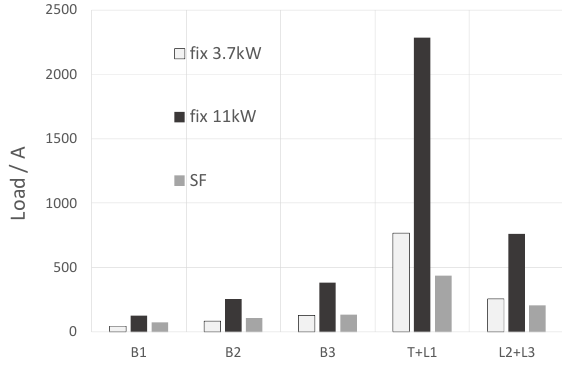
Fig. 7. Results for the different calculation approaches